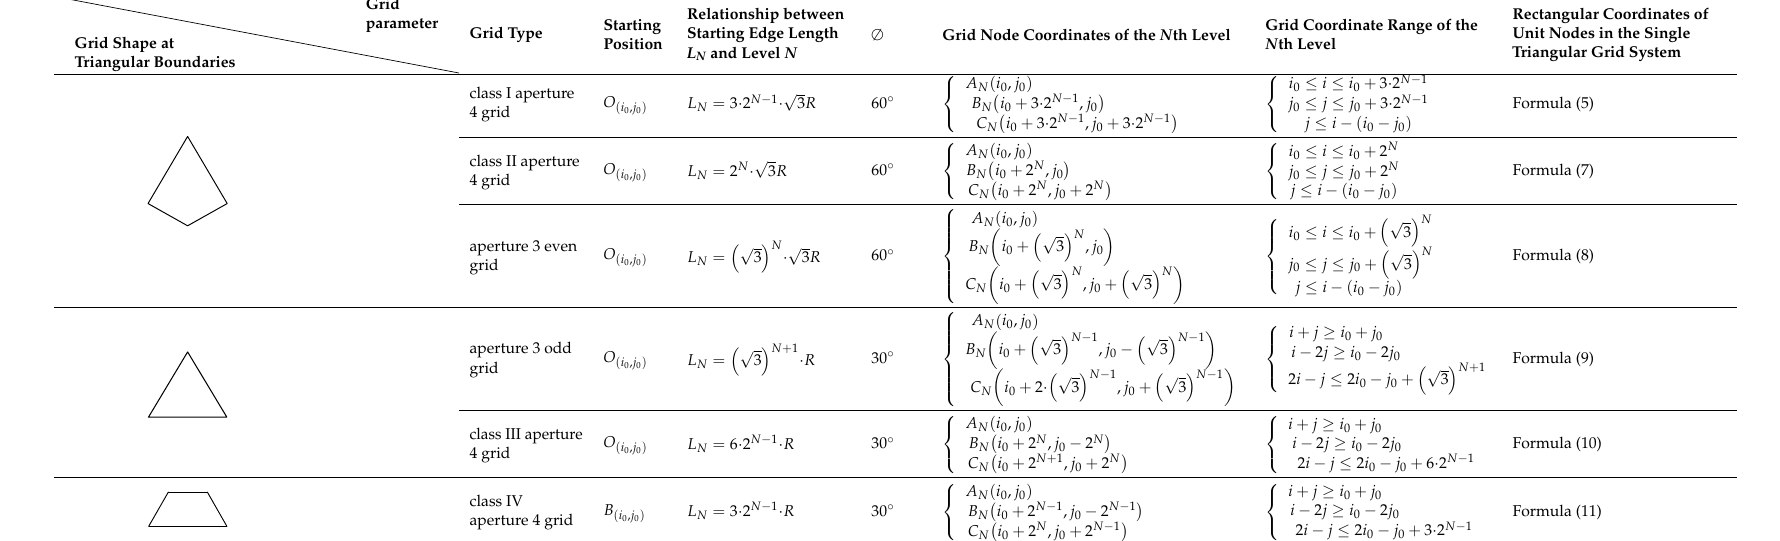
Note: Formula (5) in the table is shown in Section 3.5. Formulas (7)–(11) in the table are shown below.